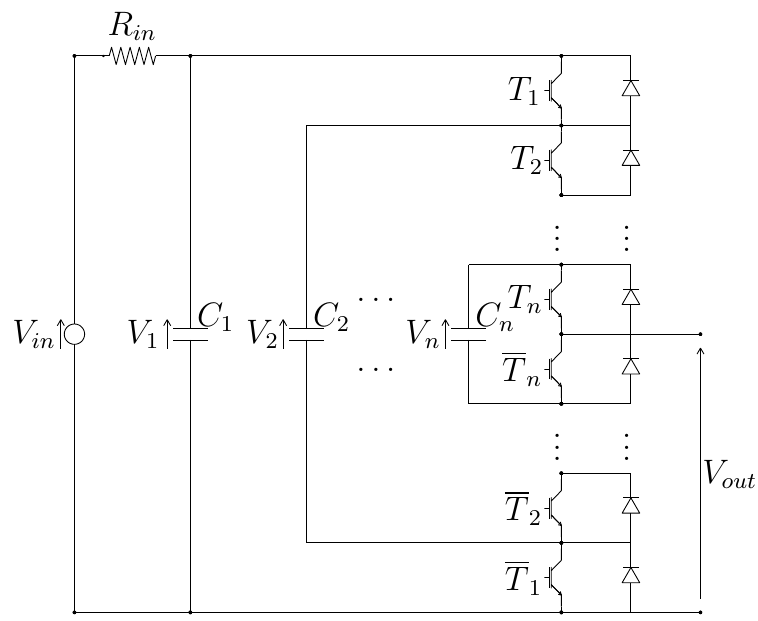
Figure 2. Electrical scheme of the n -dimensional Multilevel Flying-Capacitor